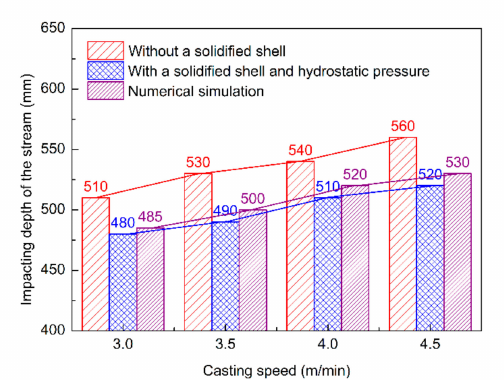
Figure 7. The impacting depth of the stream in three kinds of